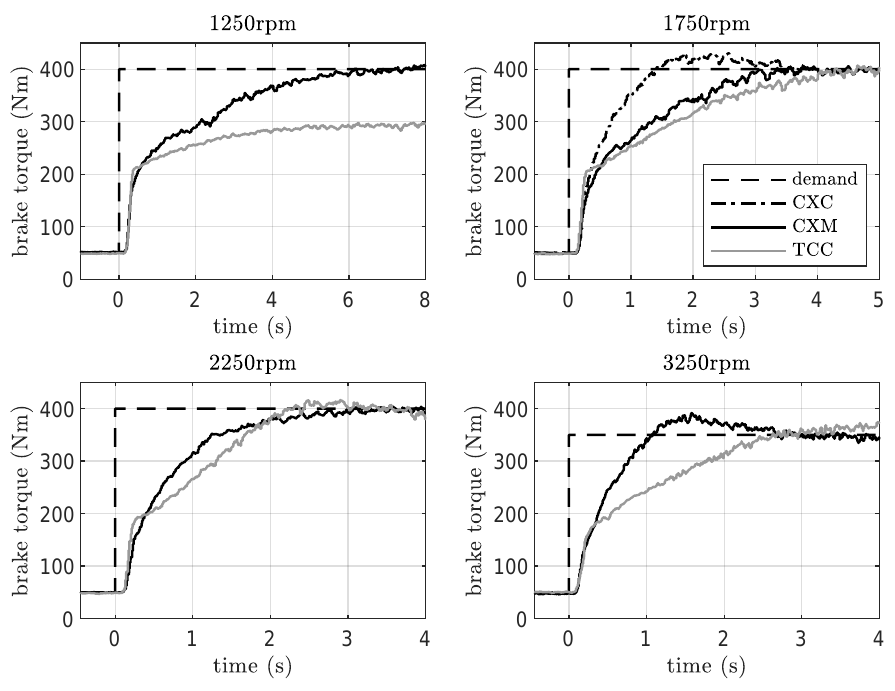
Figure 15. Load steps at several engine speeds using two (three) different engine concepts: Comprex with Miller camshaft (CXM), Comprex with conventional camshaft (CXC) and turbocharger with conventional camshaft (TCC). Notice the different scaling of the x-axes.